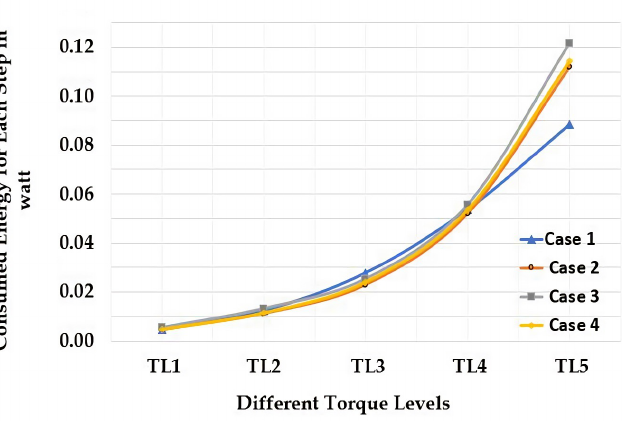
Figure 7. The energy consumption of walking with different Q and R matrices and torque